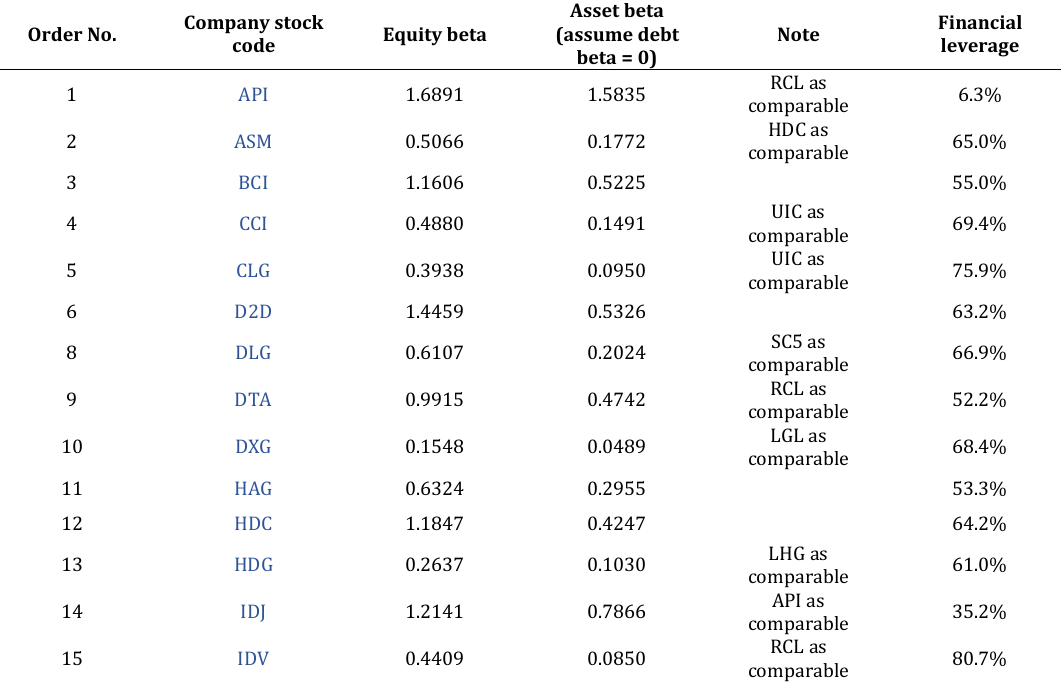
Table 2: Market risks of listed real estate firms (t = 28%) Order